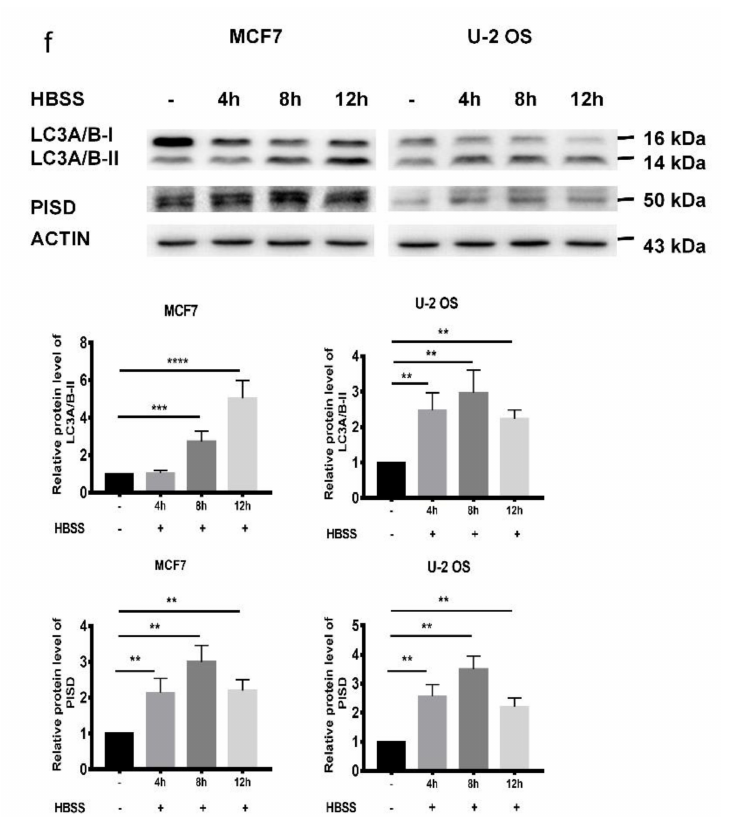
Figure 2. Decreased PISD results in the inhibition of autophagy in TFAM knockdown cells. ( a ) Western blotting analysis of protein levels of PISD and qRT-PCR analysis of mRNA levels of PISD in TFAM knockdown cancer cell lines. ( b ) The protein levels of LC3-II and PISD in sh-C and sh-TFAM transfected cells after treatment with HBSS for six hours. ( c ) The protein levels of LC3-II after downregulating the expression of PISD. ( d ) Under HBSS treatment, the protein levels of LC3-II in U-2 OS and MCF7 cells after downregulating the expression of PISD. ( e ) The mRNA levels of PISD in tumor cells after treatment with HBSS for 3, 6, and 9 hours. ( F ) The protein levels of PISD and LC3-II in tumor cells after treatment with HBSS for 4, 8, and 12 hours. Each independent experiment was repeated three times or more, and data are presented as the mean ± SD. * p < 0.05, ** p < 0.01, *** p <